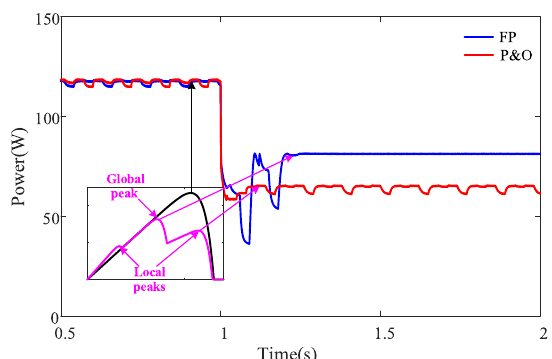
Fig. 9 Tracking performance by P&O and proposed algorithm under partially shaded